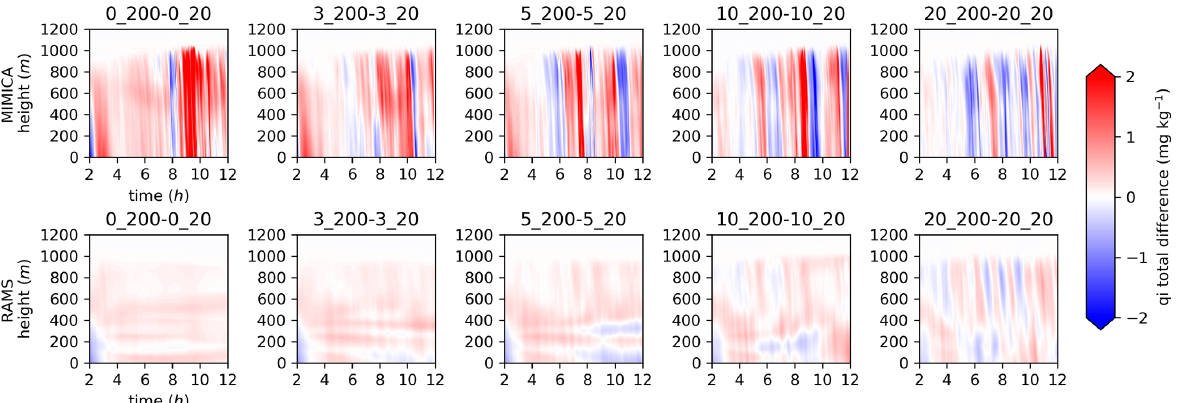
Figure 9. Differences in total ice mixing ratio (qi total) for simulation pairs with the same accumulation mode concentration (i.e. ACx_AK200–ACx_AK20) shown for MIMICA and RAMS. The first 2h of simulations, considered as the spin-up period, are excluded. A Student’s t test with a 95% confidence level shows that the (time mean) differences are statistically significantly different in the first four pairs of simulations in both models. For figure clarity, the plot titles have been abbreviated; the first number refers to the accumulation mode and the second to the Aitken mode concentration in cubic centimetres, i.e. 0_20 refers to AC0_AK20.